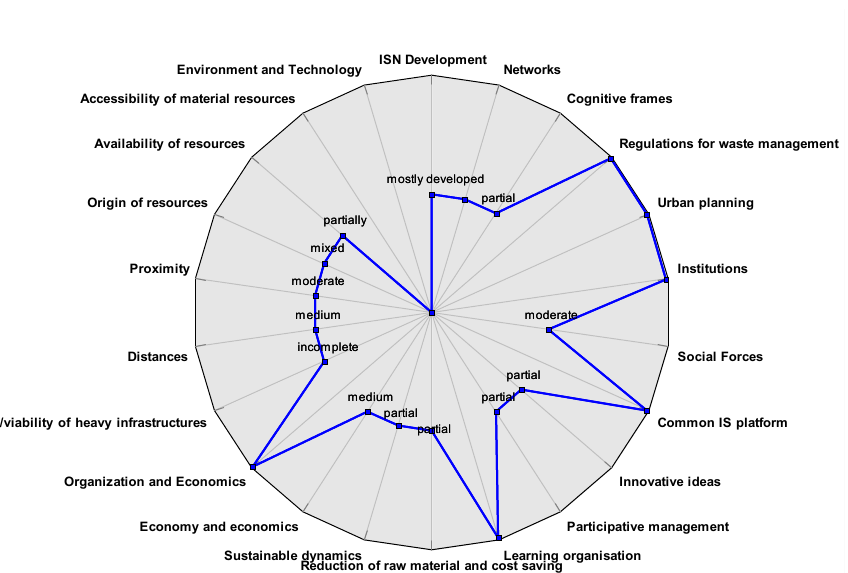
Figure 6. Polar chart of the selected attributes for ISN in Kwinana.